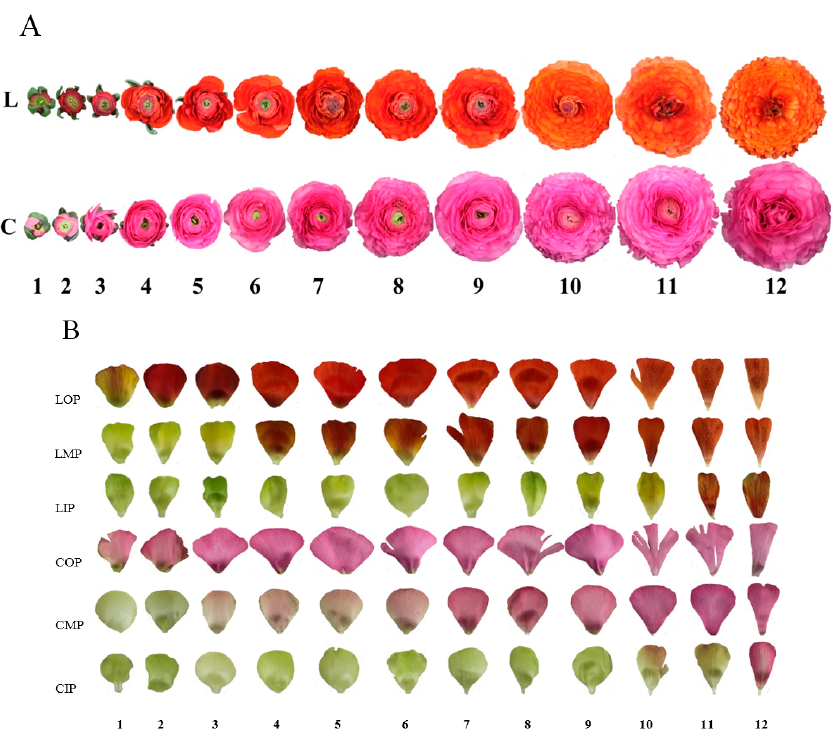
Figure 1. Flowers and petals at 12 development stages and three layers of two varieties of Ranunculus asiaticus L. ( A ) flowers; ( B ) petals; L: ‘Jiaoyan zhuanhong’; C: ‘Jiaoyan yanghong’; 1–12: stage